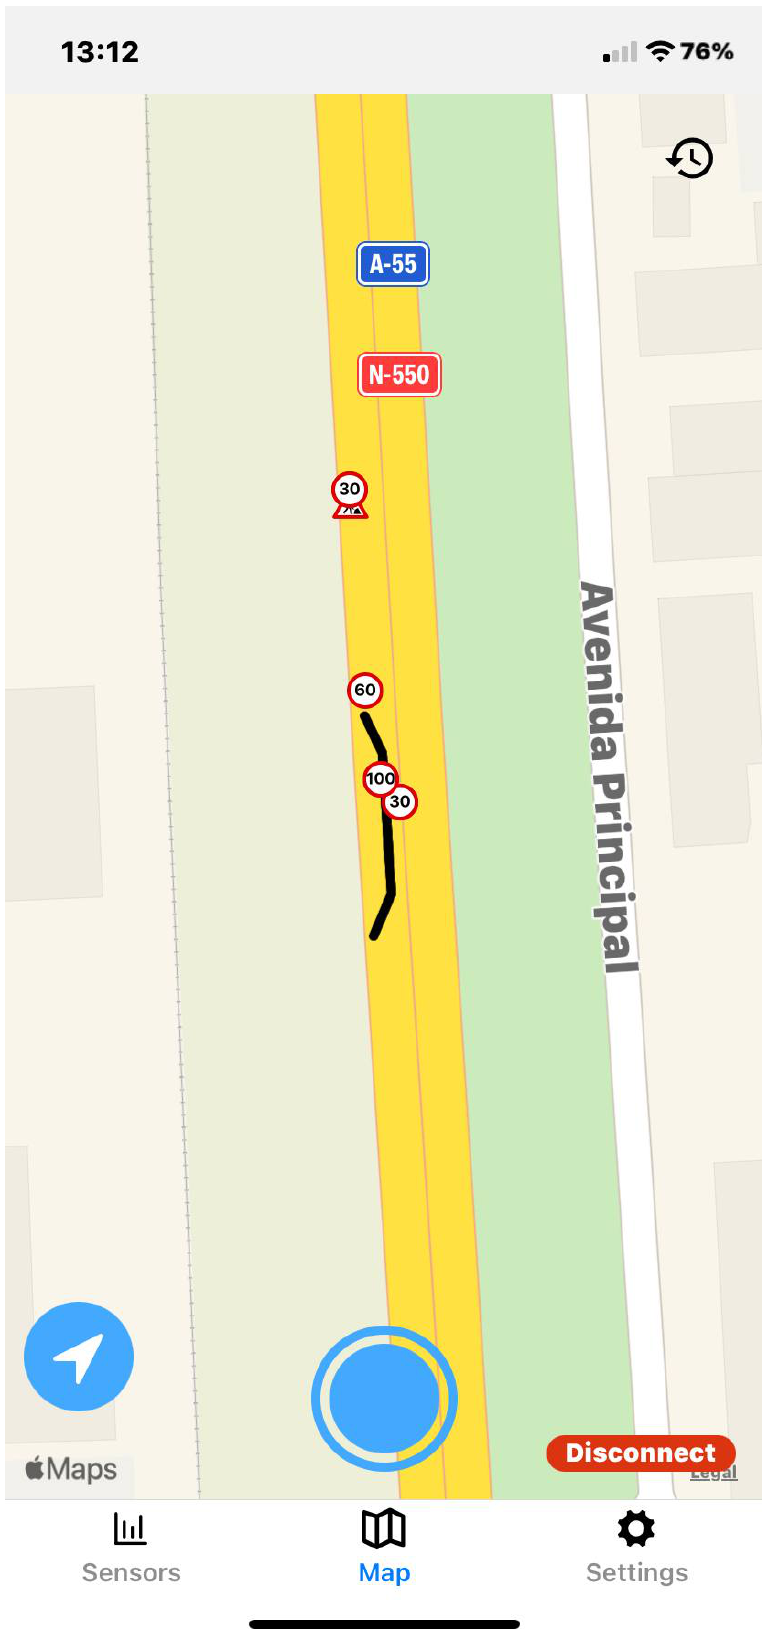
Figure 10. HD-Map message representation in the mobile